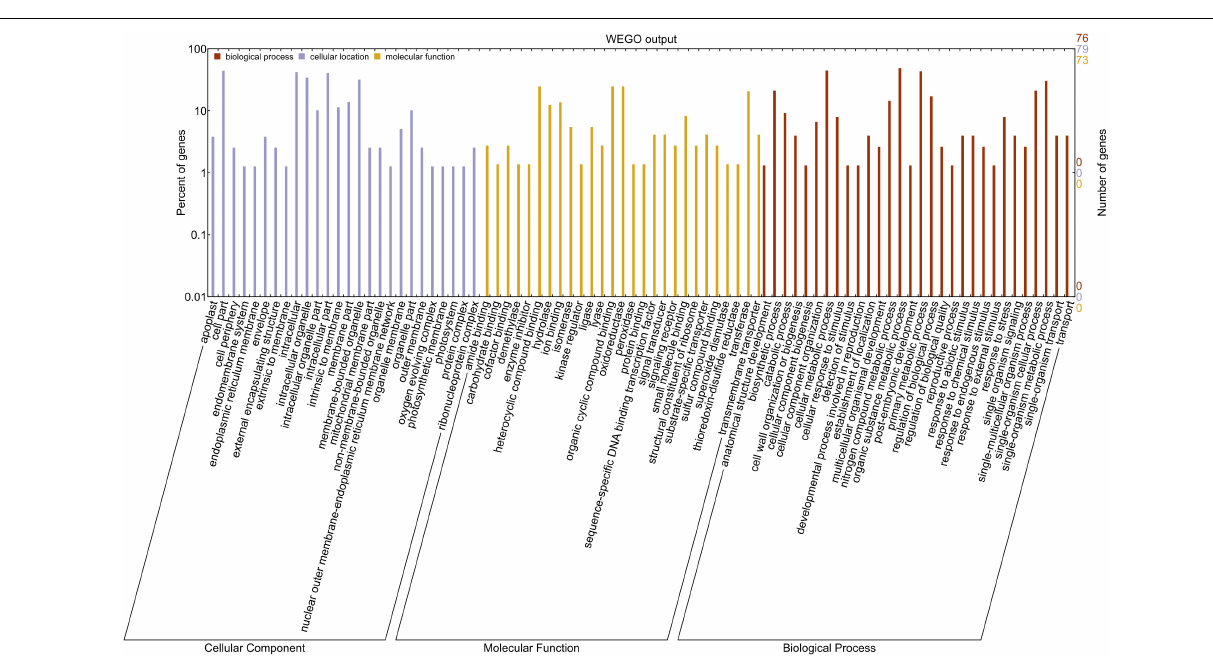
FIGURE 6 | The gene ontology analysis of the heat-responsive miRNAs-targeted genes in wheat. The red, yellow, and blue bars symbolize biological process, molecular functions, and cellular components, respectively. The x -axis represents three GO categories; the right side of y -axis represents the number of miRNA target genes, while the left side of y -axis represents the percentage of the target